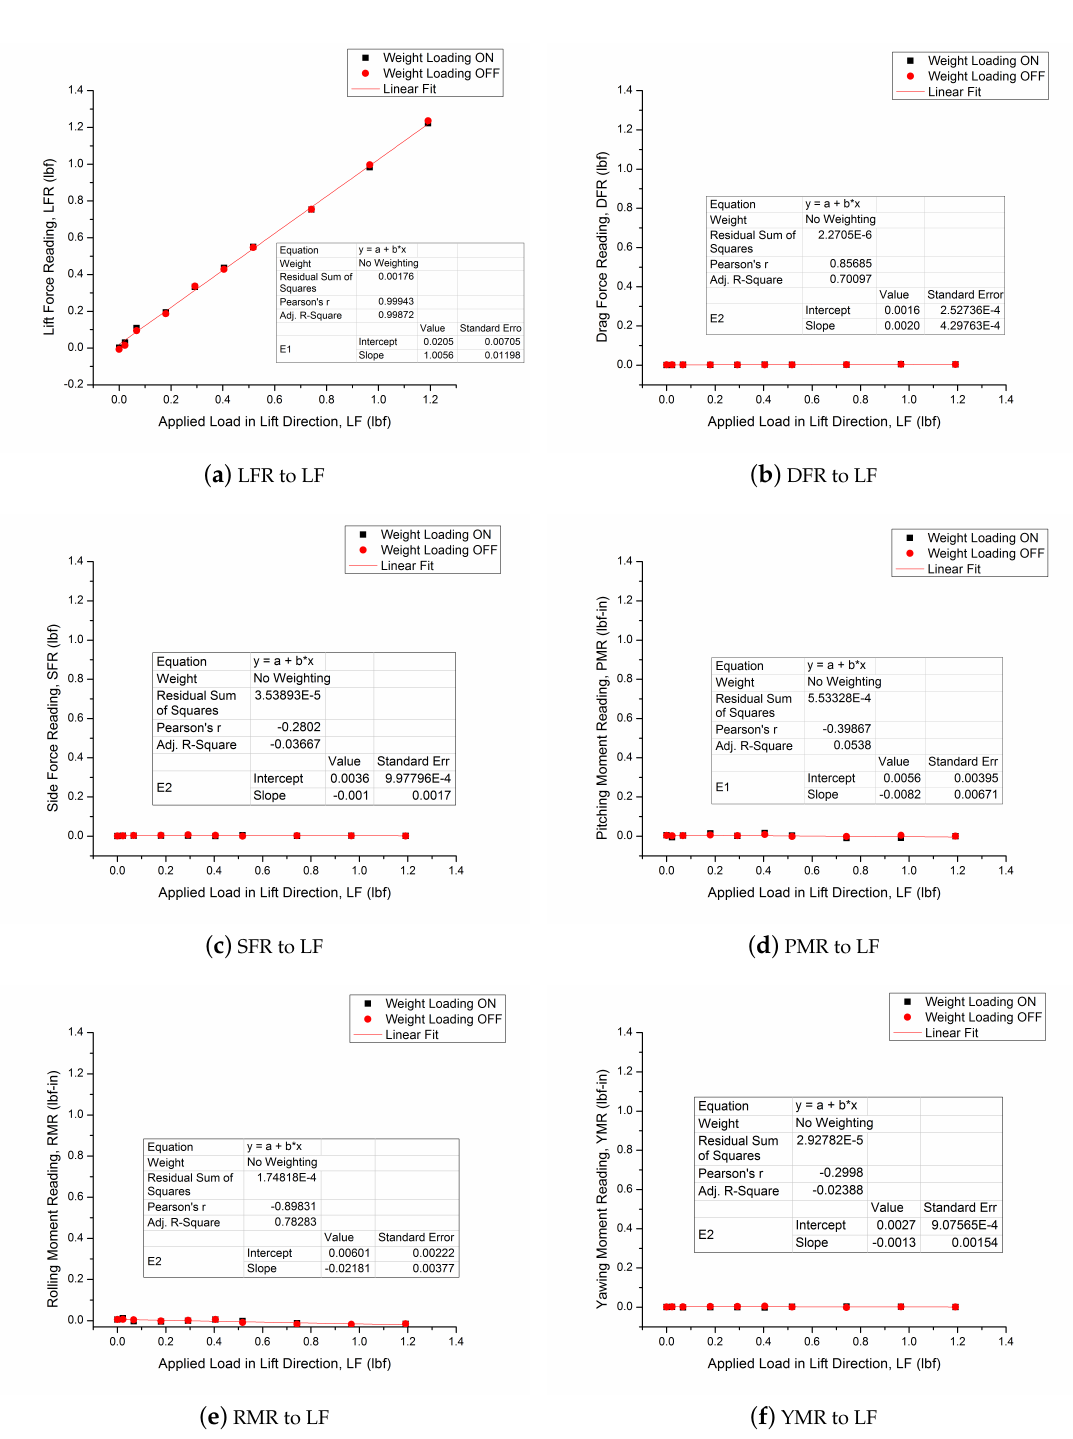
Figure A1. Experimentally obtained wind tunnel pyramidal balance interactions upon applied load in lift force